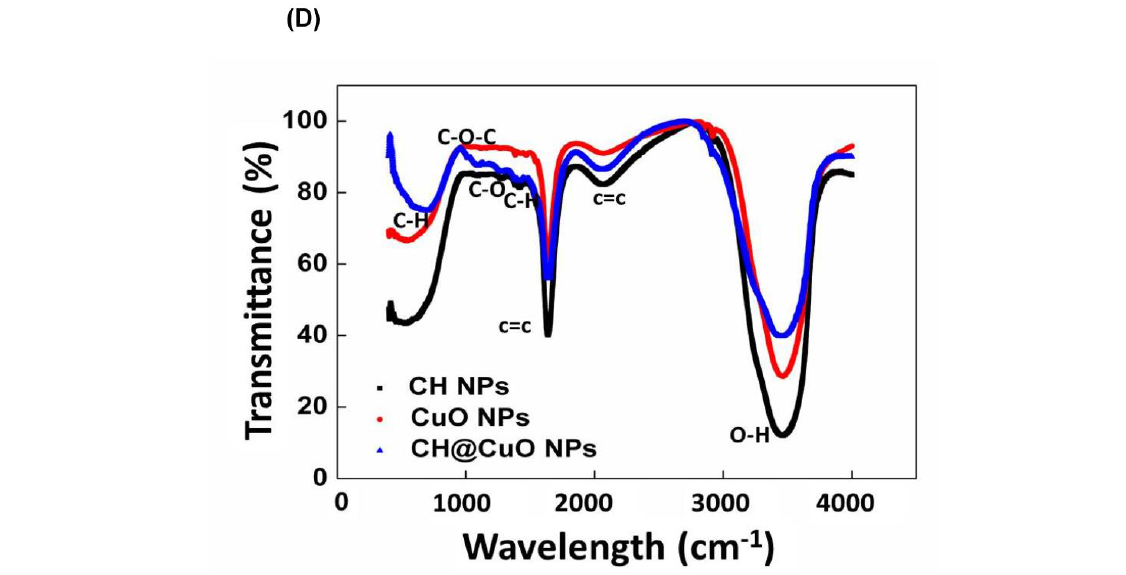
Figure 1. Transmission electron microscope (TEM) images of CH NPs ( A ), CuO NPs ( B ), CH@CuO NPs ( C ) and the FTIR spectrum of CH contained several peaks representing functional groups ( D ). cinerea